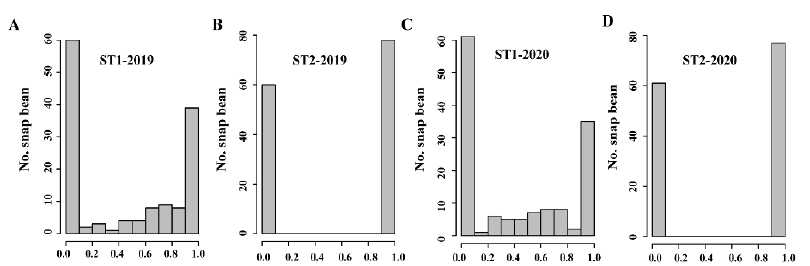
Figure 1. Histograms of pod suture strings in 138 snap bean accessions. ( A ) The ratio (string length/pod length) was measured in 2019. ( B ) The rating (1 for the presence of a string and 0 for the absence of a string) was determined in 2019. ( C ) The ratio was measured in 2020. ( D ) The rating was determined in 2020. ST1: the ratio of string length to pod length; ST2: the rating of whether there are strings (1 for the presence of a string, and 0 for the absence of a string).